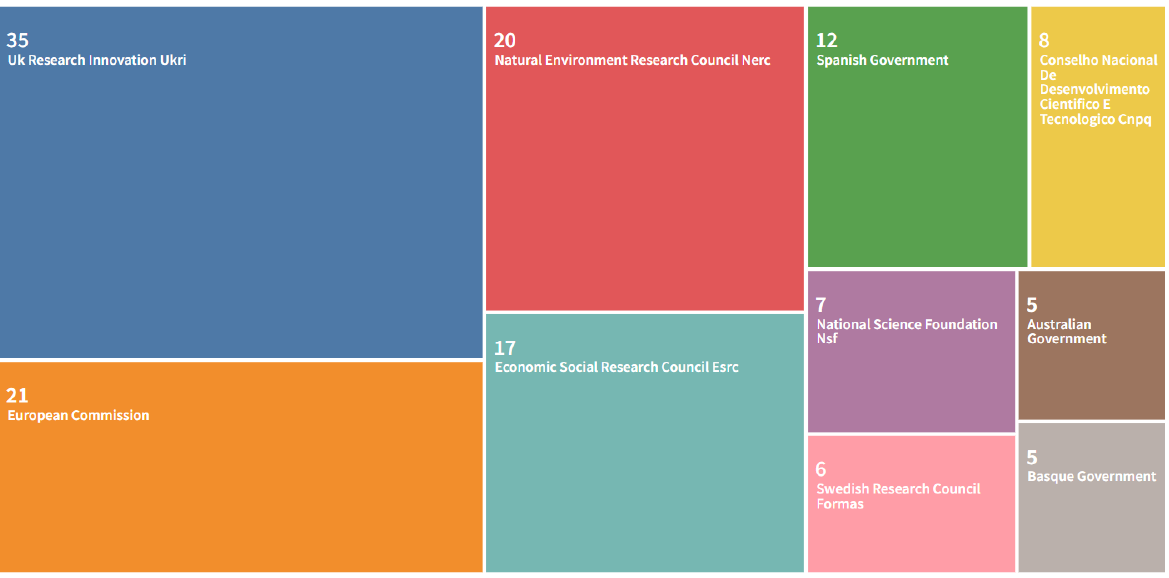
Figure 14. The visualisation tree map of the top 10 funders for the research on environmental valuation (data retrieved from WoS database on 22nd October 2022).